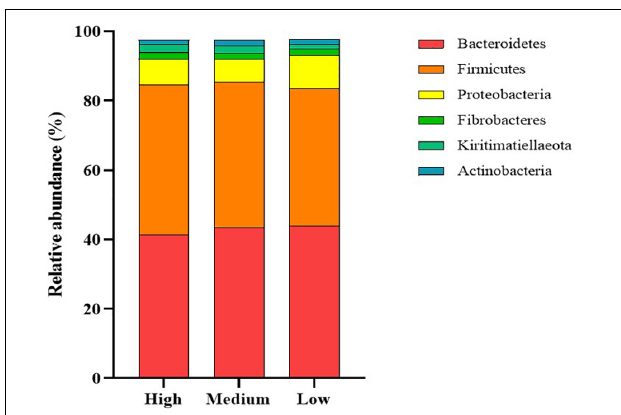
FIGURE 1 | Stack plot comparing differences, in the relative abundances of the six most abundant rumen bacterial phyla, between cattle ranked as high, medium, and low for residual methane emissions.